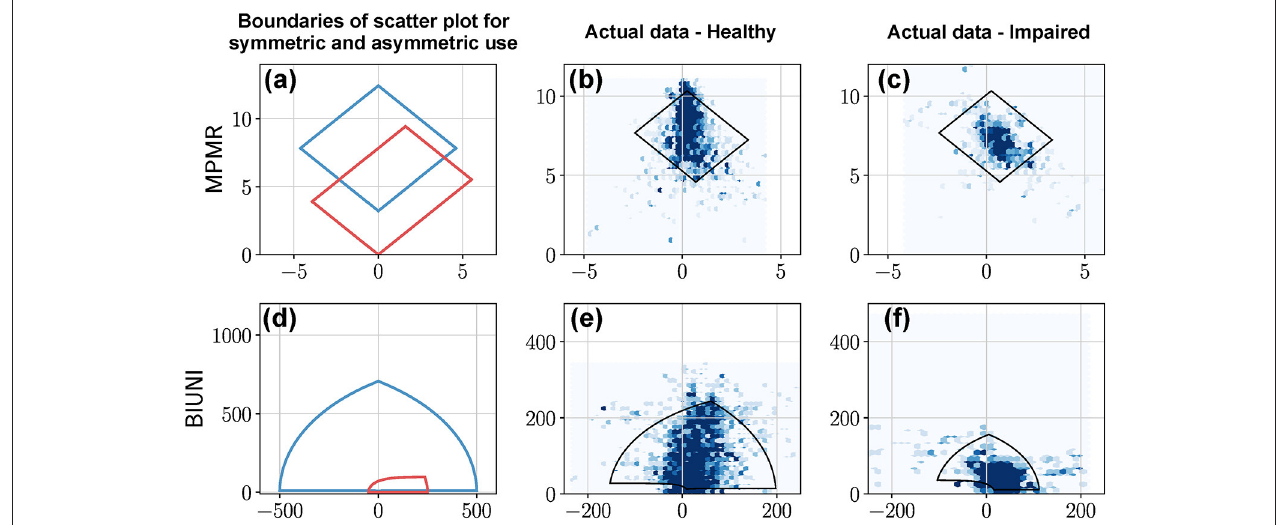
Figure A 2 | MPMR, and BIUNI plots of actual data from a healthy and impaired participant. The first column shows (a,d) examples of the boundary of the distribution of scatter plots for the MPMR and BIUNI plots for symmetric and asymmetric upper-limb use. This closed curve corresponds to the L 1 and L 2 curves for different values of I r and I l . (b,c) Depict the MPMR scatter plots for a healthy and impaired participant using data collected during a single day. (e,f) Corresponding BIUNI plots for the same subjects. The closed black curves shown in the plots for the healthy and impaired participant correspond to the 2.5th and 97.5th percentiles for I l and I r